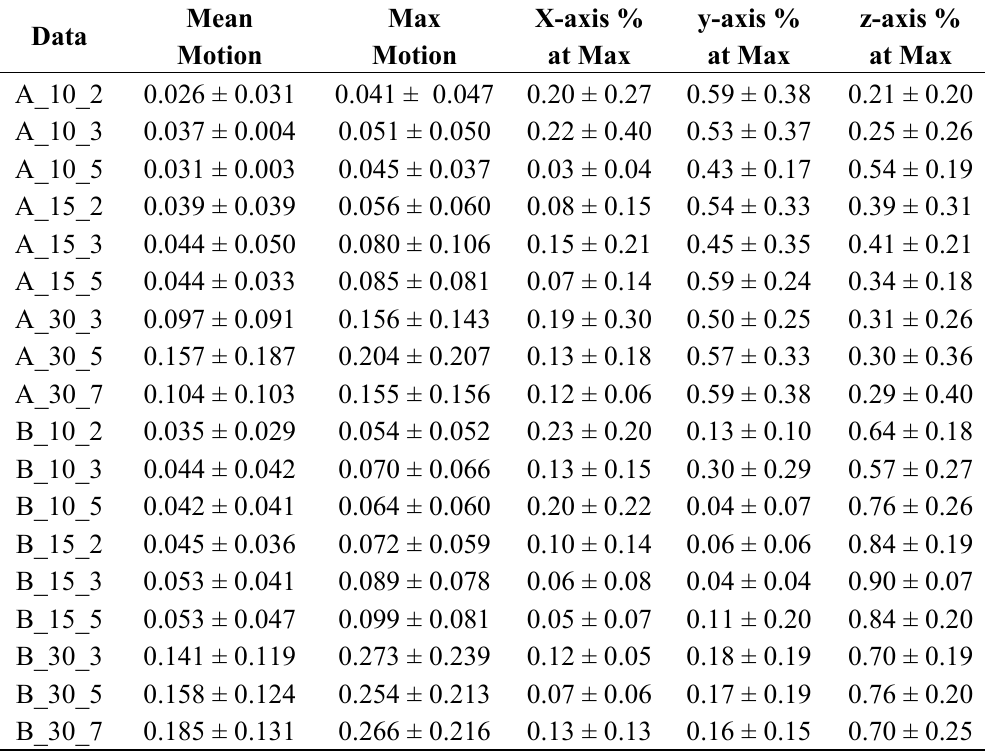
Table 1. Mean and maximum motion index of Experiment 1C. First label is motion direction, the second is angle and the third is sway number. For example, A_10_2 means left-to-right sway for 7 times with 10 degree in 2 second.